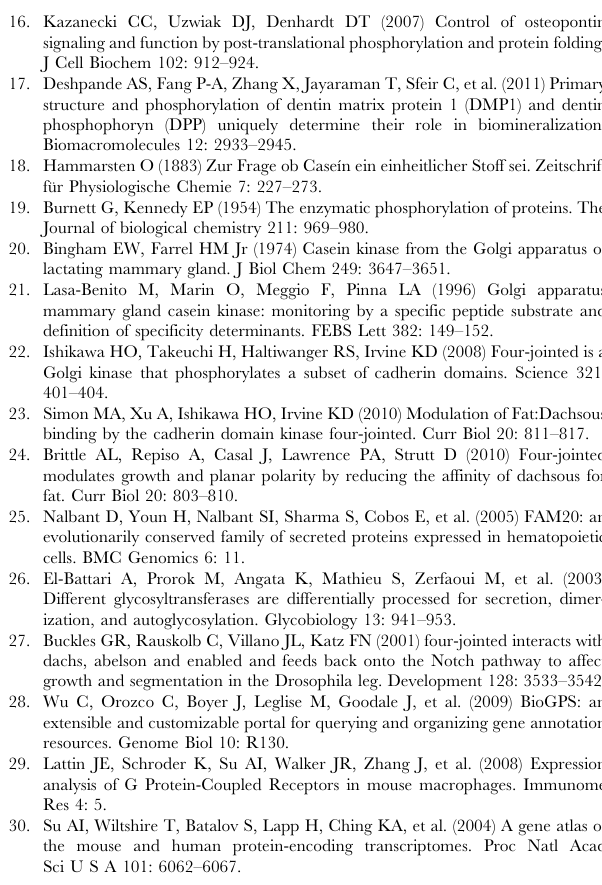
Figure S2 Localization of FAM20 proteins. A–f Localiza- tion of the indicated V5-tagged FAM20 proteins (green) transfected into HEK293T cells (a–d) or S2 cells (e–f) as compared to Golgi markers (Giantin, a,c, or p120 Golgi, e,g, magenta) or an ER marker (anti-KDEL, magenta). g) Localization of FAM20C (green) in MC3T3 cells is clearly distinct from an ER marker (KDEL). Panels marked by prime symbols show single channels of the merged image to the left. h) Western blot showing that FAM20C:V5 expressed in HEK293T cells is detected in both lysate (L) and medium (M), FAM20A and FAM20B are only detected in cell lysate. Figure S3 Additional characterization of Kinase activity of FAM20C. All panels show the results of kinase assays using dephosphorylated alpha casein as a substrate, and affinity purified FAM20C:V5 as the enzyme. a) Dependency of kinase activity on pH. b) Dependency of kinase activity on calcium concentration.